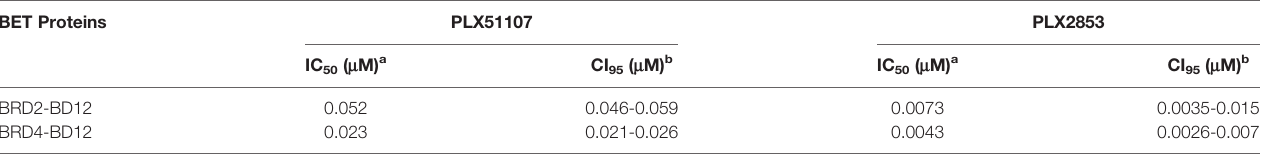
TABLE 1 | IC 50 values for PLX51107 and PLX2853 against BET proteins. BET